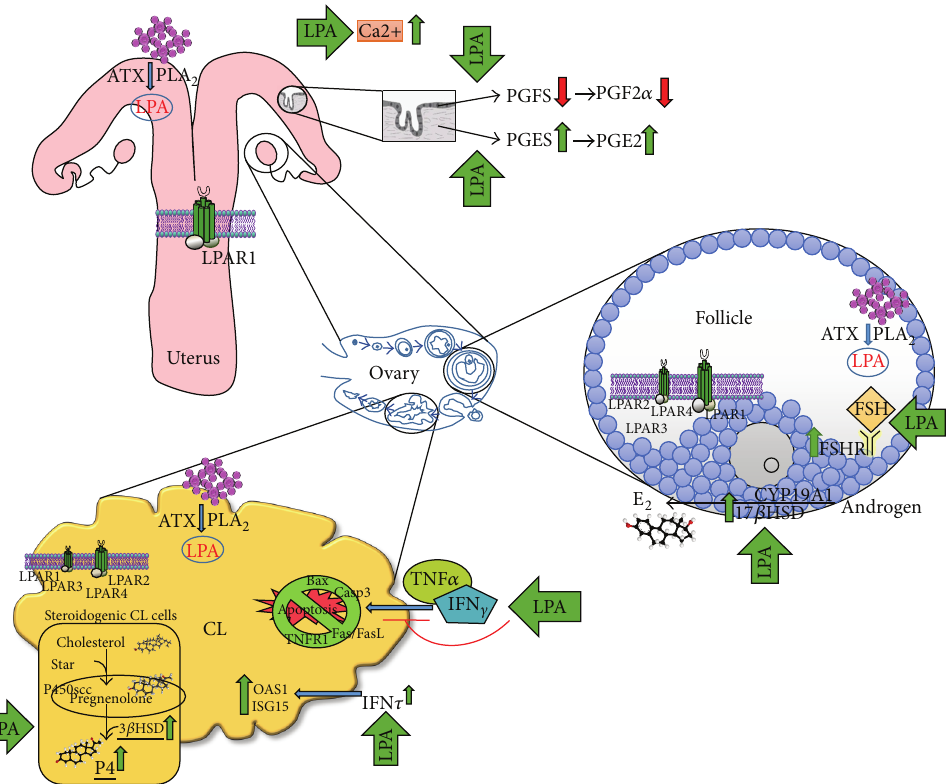
Figure 1: Schematic model illustrating the possible lysophosphatidic acid signaling in the bovine reproductive tract (LPA—lysophosphatidic acid; LPAR—lysophosphatidic acid receptor; PGFS—prostaglandin F 2𝛼 synthase; PGES—prostaglandin E 2 synthase; ATX—autotaxin; PLA 2 —phospholipase A 2 ; FSH—follicle stimulating hormone; FSHR—follicle stimulating hormone receptor; E 2 —estradiol;